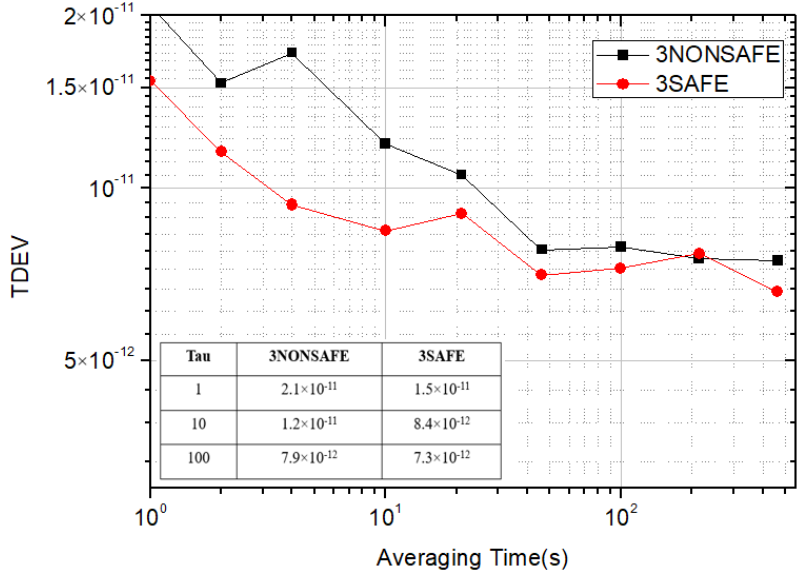
Figure 9. Comparison of jitter using three safe and non ‐ safe equipment.